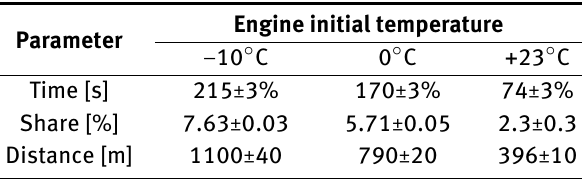
Table 3: Average values of the time of switching the fueling from gasoline to LPG, the share of gasoline consumption in the total fuel consumption and the distance traveled when running on gasoline in the WLTC cycle for various initial engine temperatures.